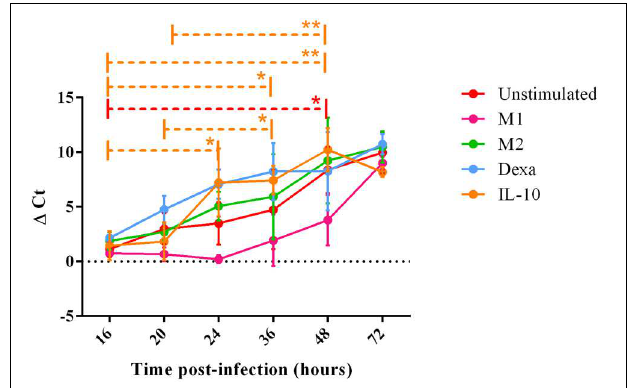
FIGURE 4 | PRRSV replication in MoMØ subset supernatant over time. Monocytes were treated as in Figure 3 . Viral RNA was extracted from cell supernatant at 16, 20, 24, 36, or 48 h p.i, and a TaqMan qPCR was used to obtain C t values. (cid:49) C t represents difference between C t at 2 h p.i (time zero) and C t at each time point p.i shown at 16, 20, 24, 36, 48, or 72 h time-points in unstimulated (red), M1 (pink) M2 (green), dexa (blue) or IL-10 (orange) treated MoMØs. Lines represent mean (cid:49) C t ± SD in three independent experiments, each biological repeat tested in duplicate ( n = 2 at 72 h p.i). ∗∗ p < 0.001, ∗ p <